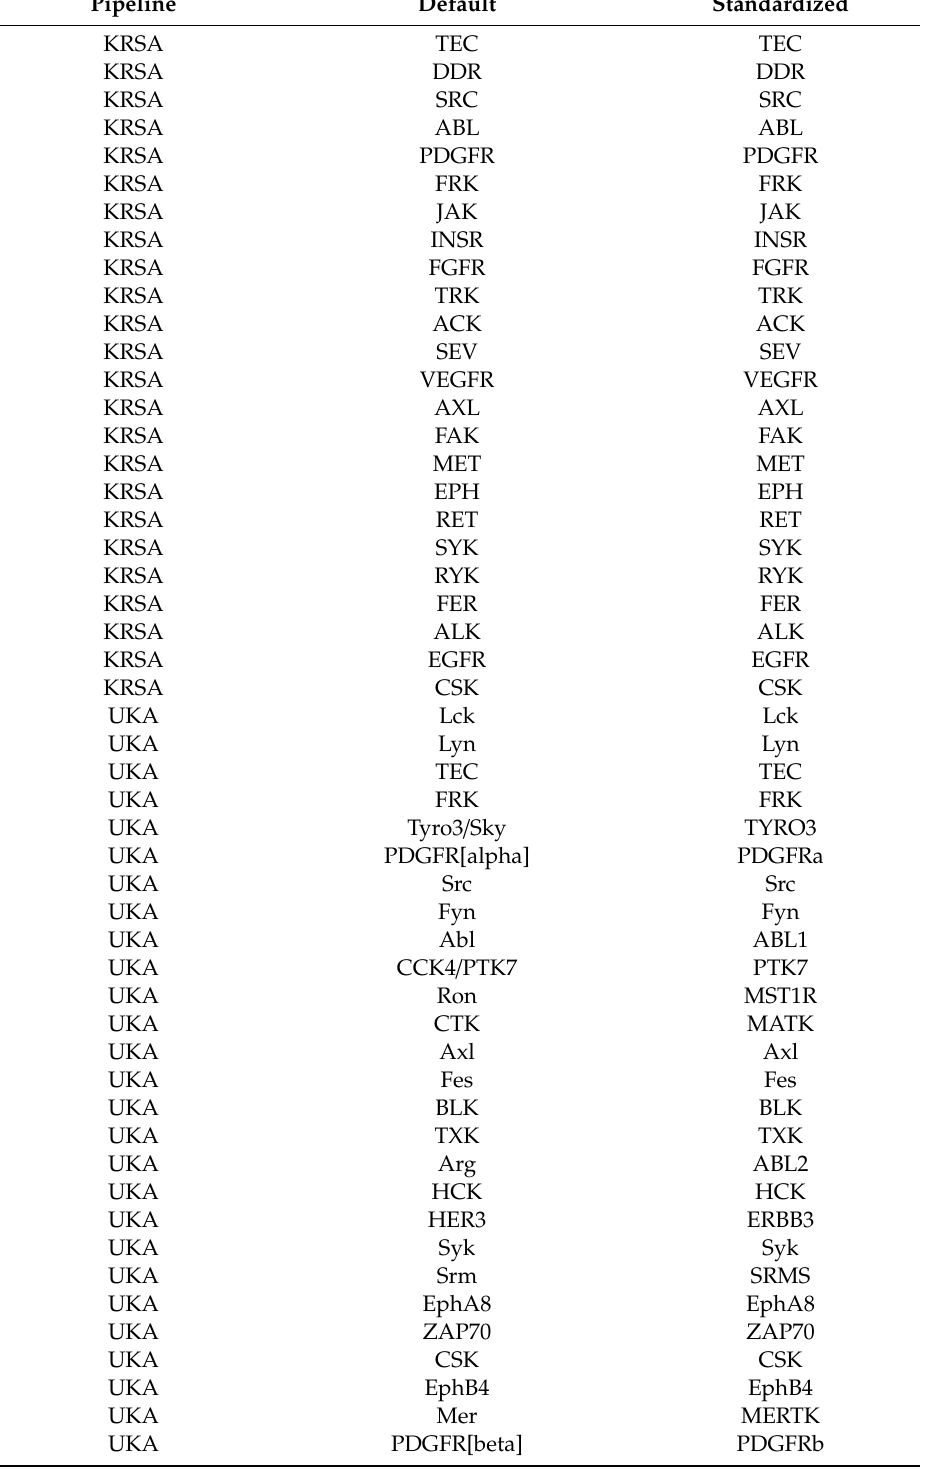
Table A4. Nomenclature